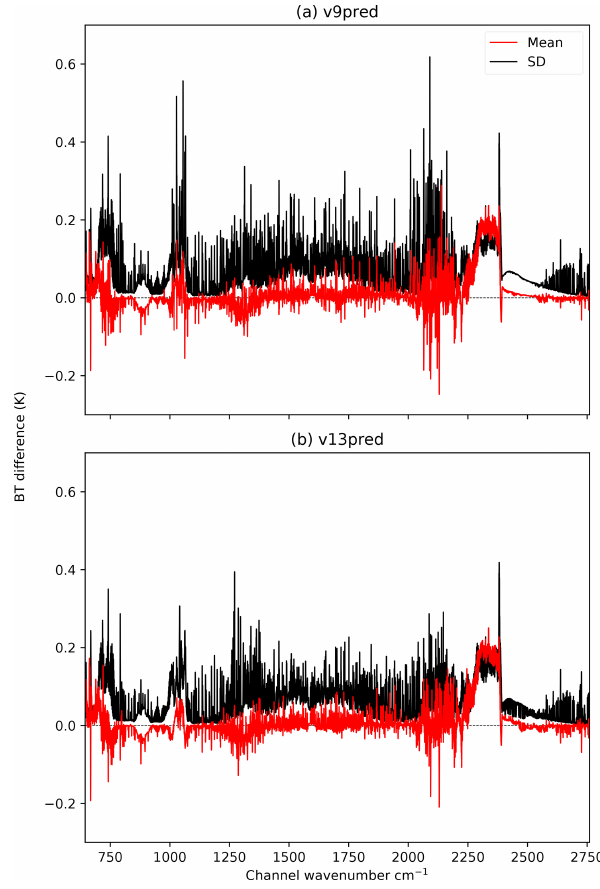
Figure 7. RTTOV vs. brightness temperatures calculated from channel-integrated LBLRTM radiances for IASI (a) v7 predictors (variable v13 O 3 ) and (b) v13 predictors (variable O 3 and CO 2 ) for 5000 independent profiles with varying water vapour and O 3 .